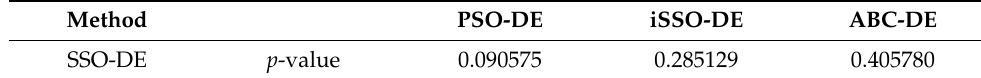
Table 25. Experimental results of Dunnett’s